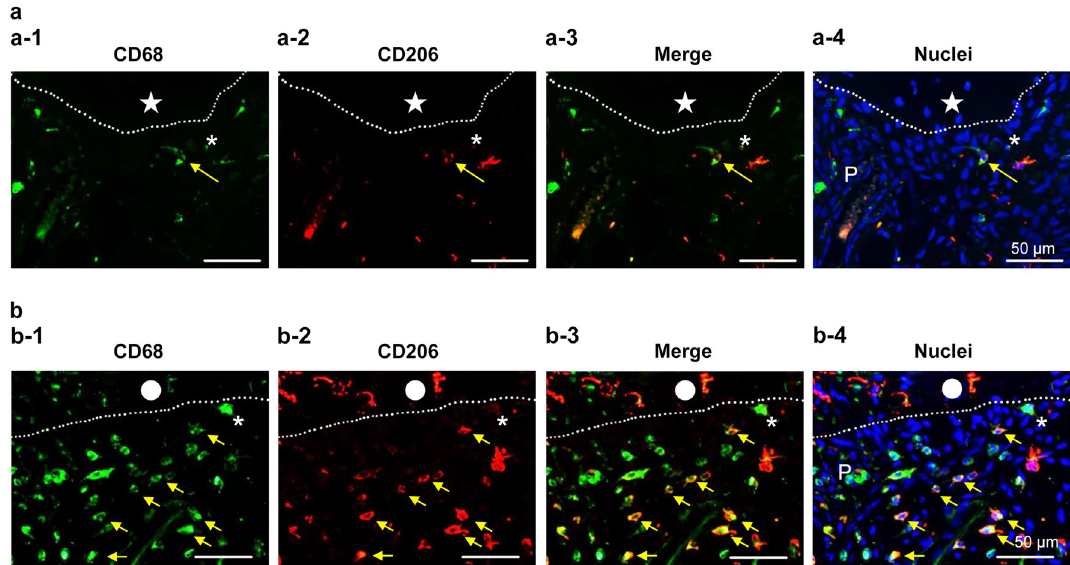
Figure 6. Immunofluorescence alteration of CD68 (green) and CD206 (red) in the pulp tissue of ODS rat 7 days after pulpotomy followed by MTA capping. Immunofluorescence of ( a ) ODS rats fed a normal diet (control; group 1), and ( b ) ODS rats fed an ascorbic acid-free diet (group 2). (a-1 and b-1) CD68 = green, (a-2 and b-2) CD206 = red, (a-3 and b-3) merged (a-1 or b-1) and (a-2 or b-2), (a-4 and b-4) nuclei = blue. CD68 positive cells in group 1 were diminished when compared with group 2. Moreover, the double-positive cells (CD68 and CD206), which indicated M2 macrophages, were also diminished in group 1. The dotted line indicates the border between the reparative dentin ( a ) or necrotic layer ( b ) and the pulp tissue. The closed star indicates the reparative dentin layer. The closed circle indicates the necrotic layer. The asterisk indicates the odontoblast-like cell layer. The yellow arrows indicate the M2